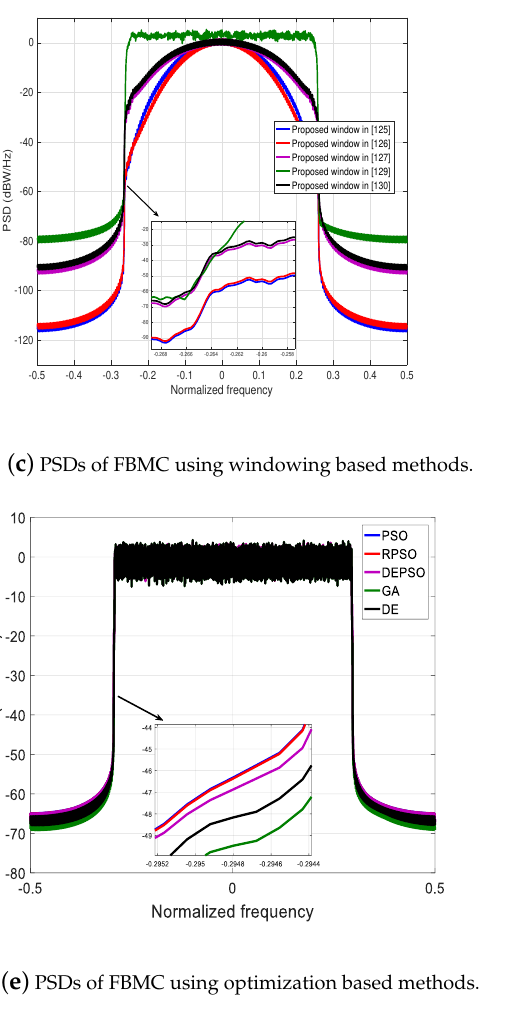
Figure 9. ( a , c , e ) The PSD performance comparison of FBMC based systems using different prototype filter design methods. ( b , d , f ) The BER performance comparison of FBMC based systems using different prototype filter design